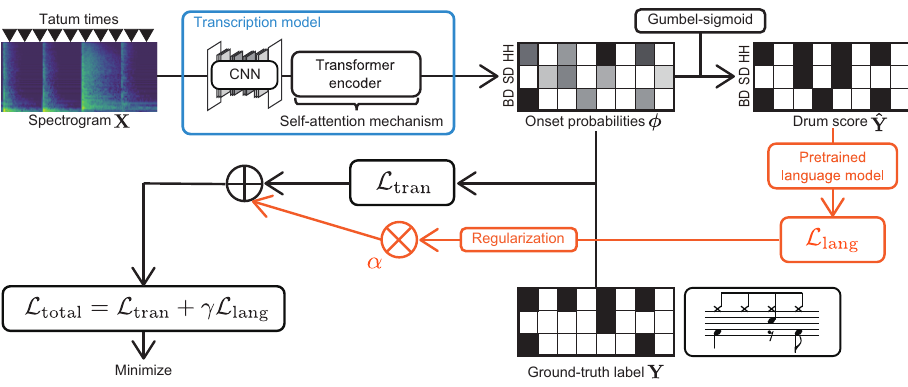
Figure 1. The supervised training of a neural transcription model (encoder–decoder model) with global structure-aware regularization based on a pretrained language